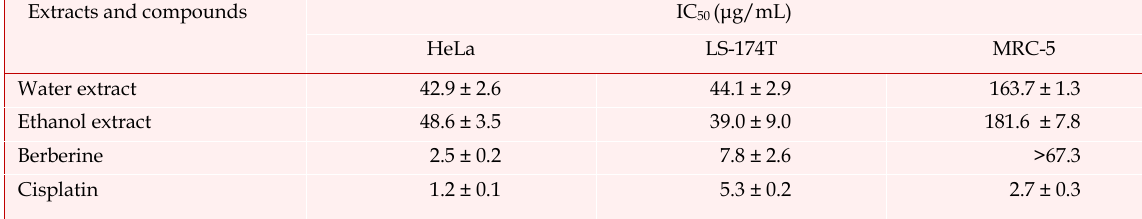
Concentration of M. aquifolium extracts that induced 50% decrease in target cell survival, after 72 hours treatment